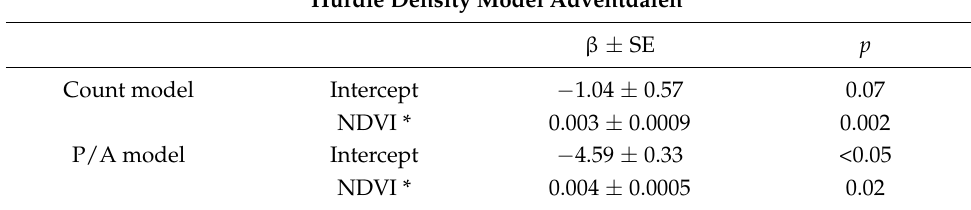
Table A2. The four candidate detection probability models for Distance sampling (DS) of Svalbard reindeer, Svalbard, Norway (July 2021). Detection probability was fitted using half-normal (hn) and hazard rate (hr) functions with weather (sunny or cloudy) as covariate (see Table S3 in Le Moullec et al. [22] for the influence of other covariates). We ranked models using Akaike’s Information Cri- terion (AIC) and differences in AIC (ΔAIC). Model